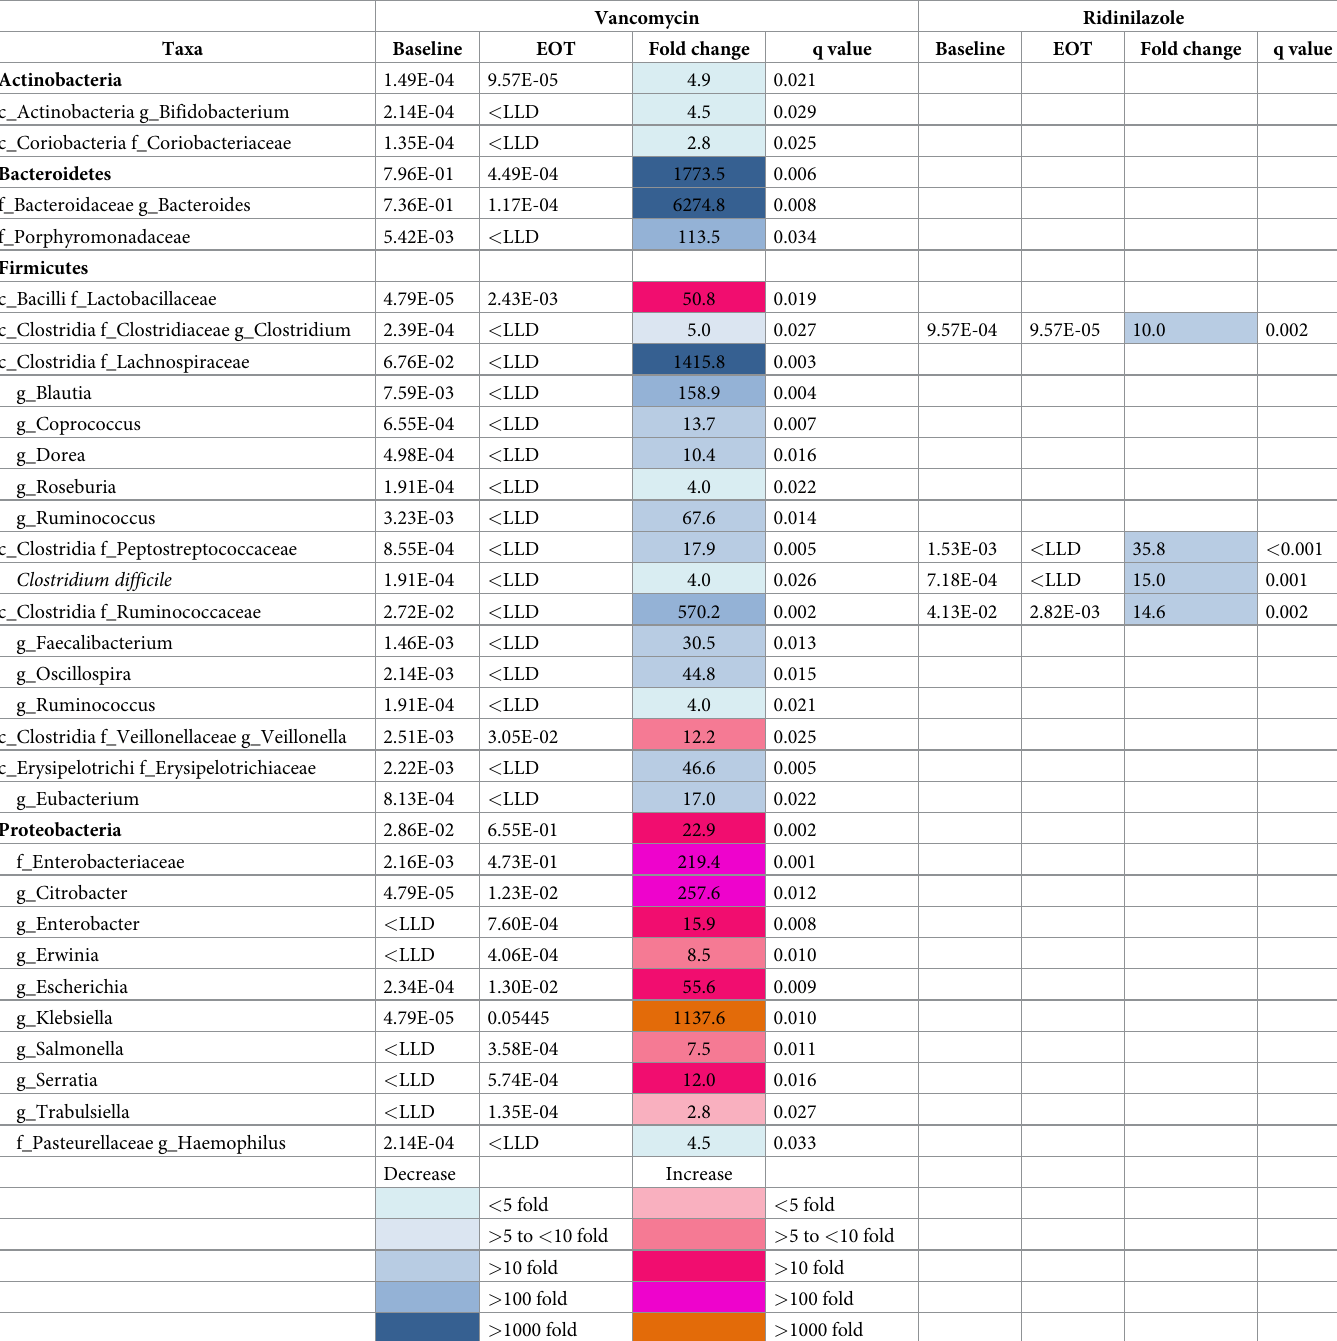
Table 3. Taxa to the genus level with (cid:21) 2-fold change in relative abundance from baseline to end of treatment (EOT) with vancomycin or